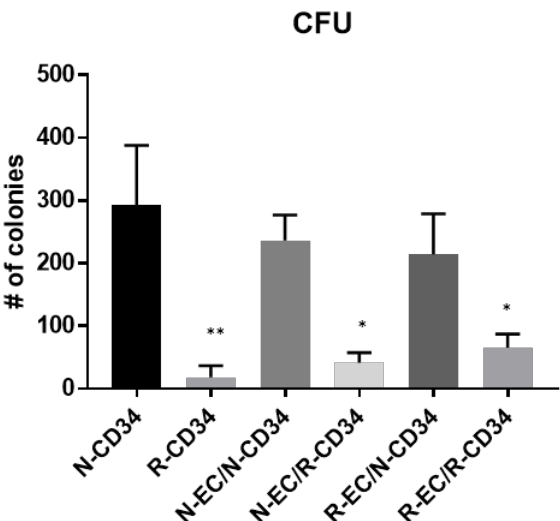
Figure 7. hBMEC slightly improved bone marrow function. Colony formation capability was improved in HSPC cocultured with hBMEC. Significance was determined compared to N-CD34. Error bars represent standard deviation. * p < 0.02; ** p = 0.006.